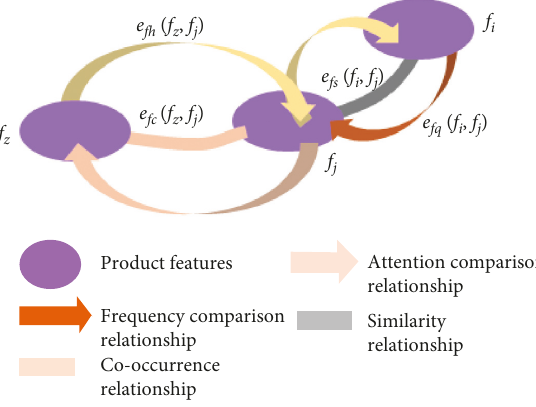
Figure 8: Co-creation product feature